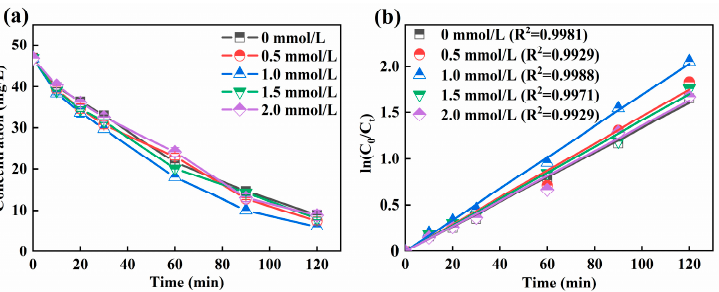
Figure 3. Decomplexation of Ni-EDTA in different Fe 2+ dosages ( a ) and kinetics fitting lines ( b ).